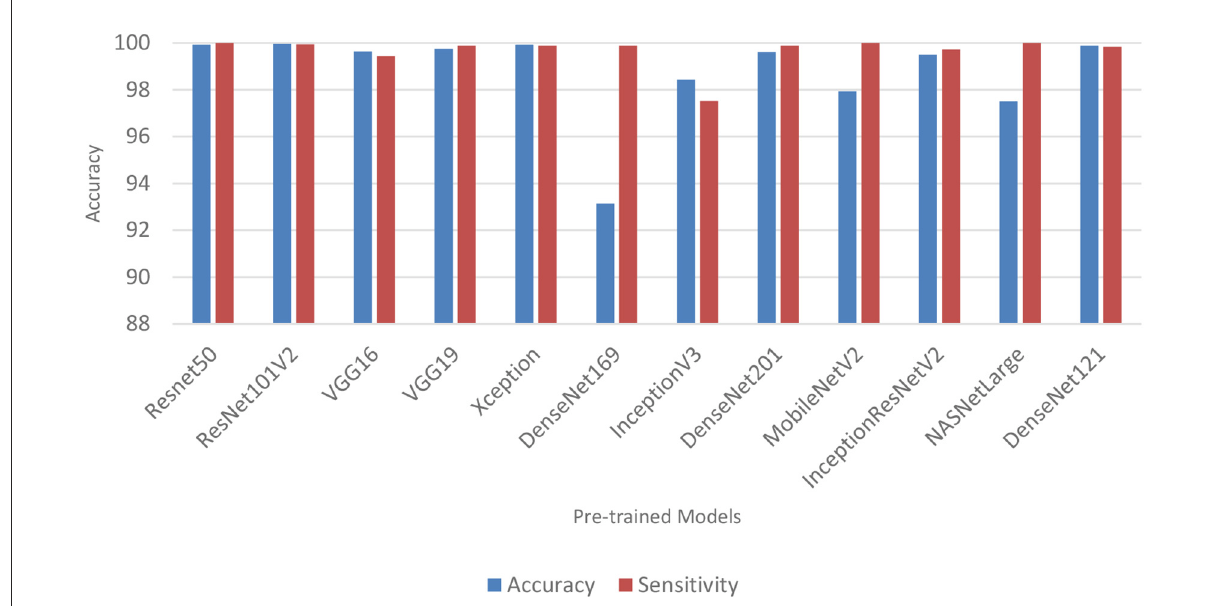
FIGURE3 Classification accuracy and sensitivity of models without data